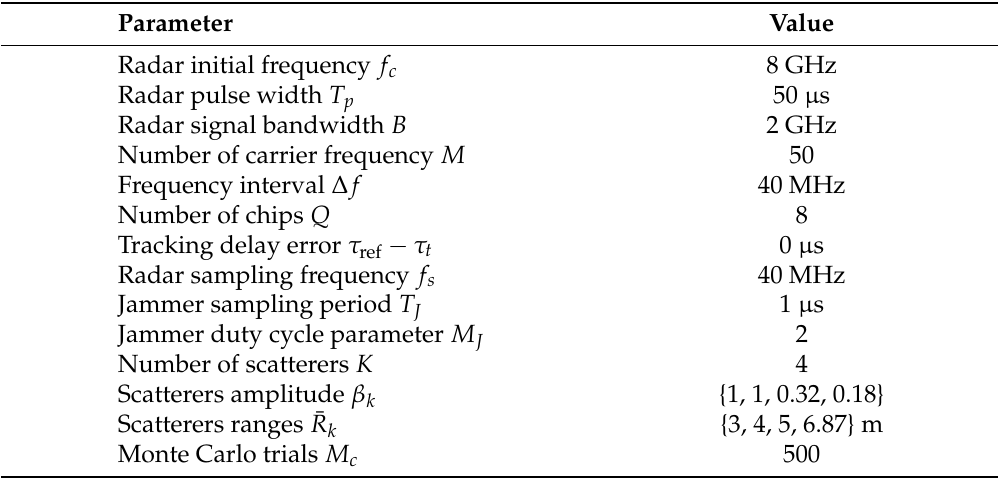
Table 1. The simulation